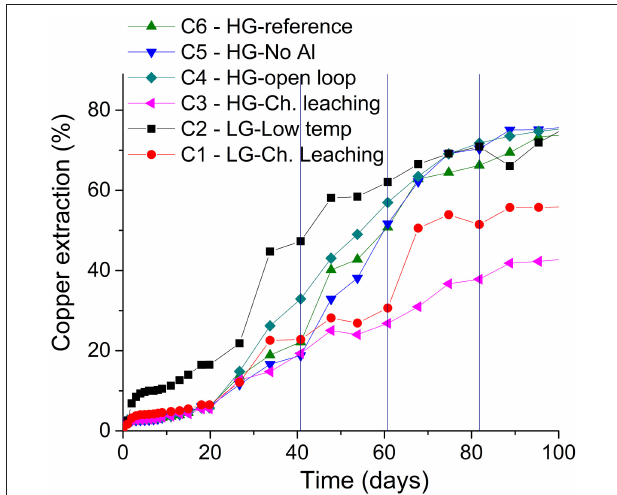
FIGURE 2 | Copper extraction from the high-grade (HG) and low-grade ores (LG). The vertical lines indicate solution bleeding. Experiments with S. thermosulfidooxidans growing in Norris growth medium supplemented with yeast extract (0.1g/L) and amended with 1.0 g/L Al 3 + (unless otherwise stated); at 50 ± 1 ◦ C (columns C1, C3–C6) or room temperature (column C2); crushed and agglomerated ore (½ ′′ top size); 8.6 L/m 2 /h solution flow-rate and 2.16 m 3 air/m 2 /h air